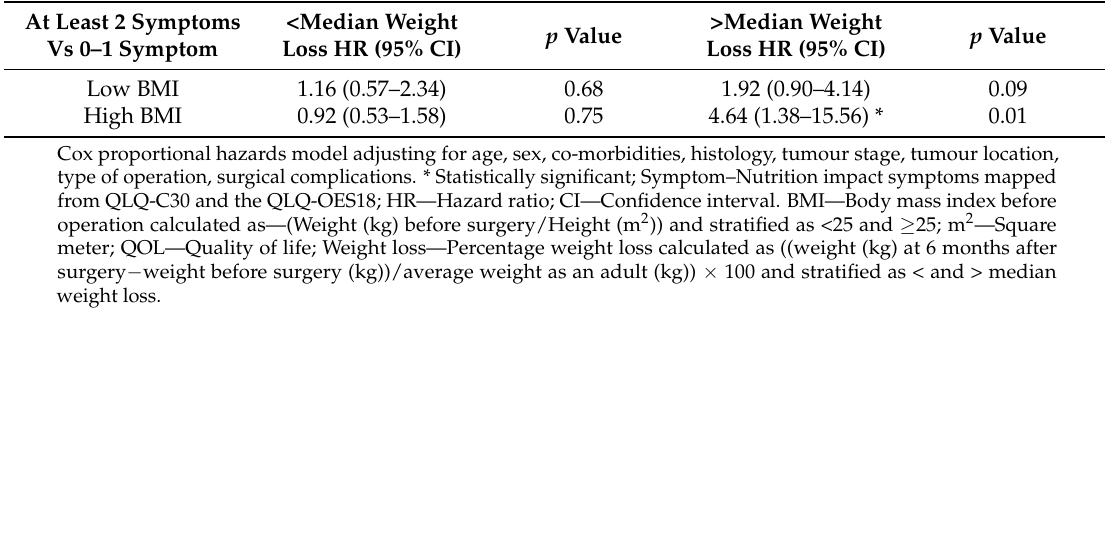
Table 3. Overall 5-year survival of patients who underwent surgery for oesophageal cancer with at least 2 symptoms versus 0–1 symptom among < and > median weight loss and low and high preoperative